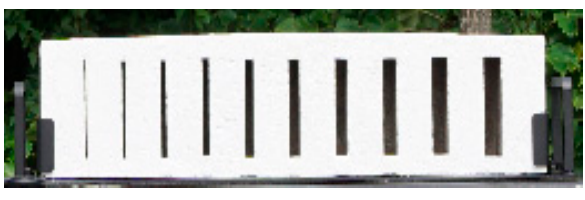
Figure 5. Complete specimen.